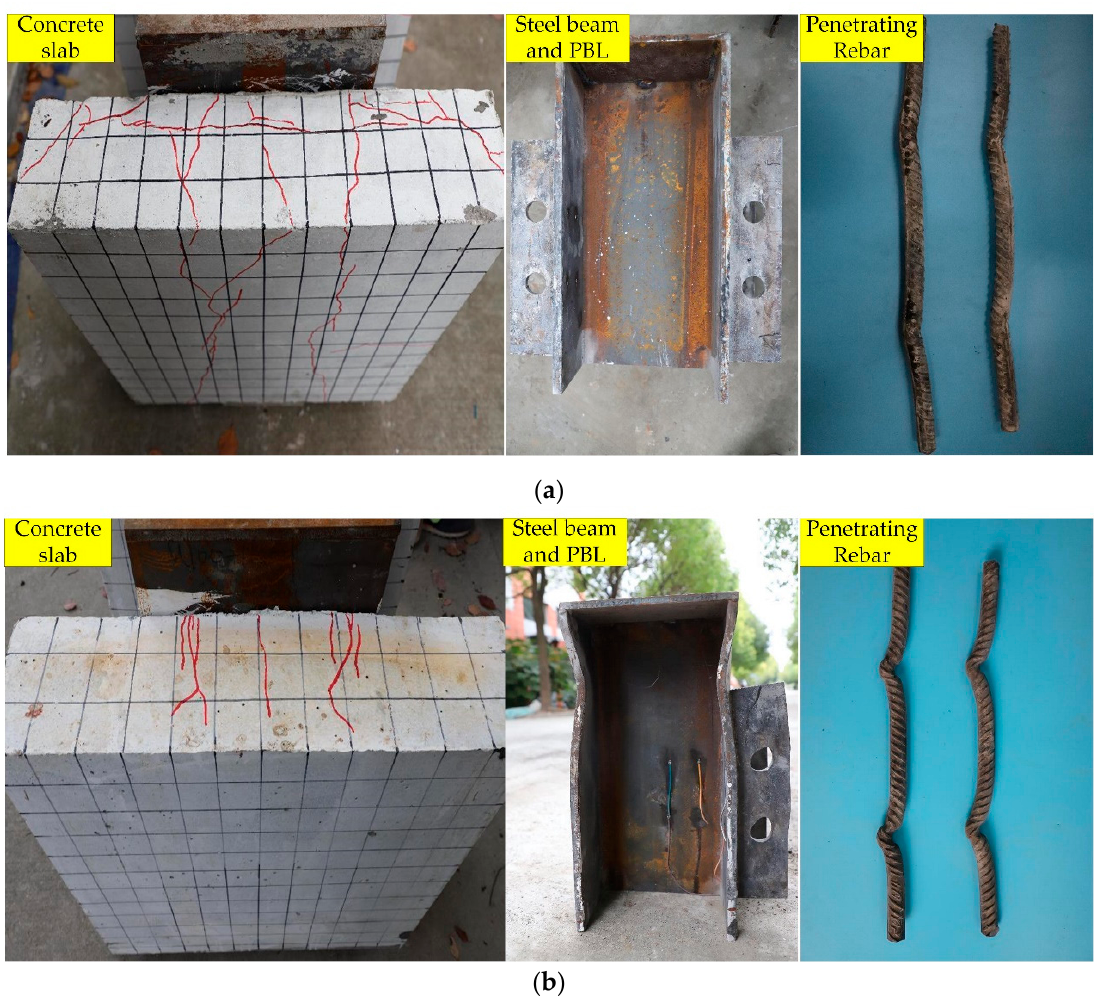
Figure 5. Failure modes of PBL shear connectors: ( a ) N-16-2 and ( b ) S-16-2.